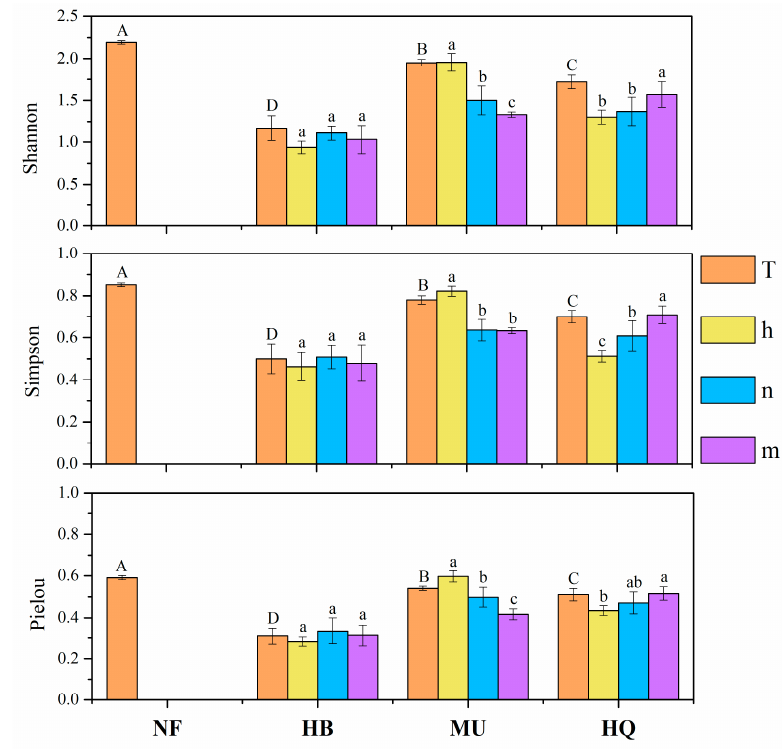
Figure 2. Diversity indices (±SE) for Ectomycorrhizae (EM) fungal communities in P. sylvestris natural forest and plantations in three sandy lands ( n =5). T for the composed value (included five mixed replicates by adding one of five samples in each age group in the same sandy land together) of each sandy land. h for half-mature, n for nearly mature, m for mature. The capital letters indicate significant differences among sandy lands (columns in orange), the lowercase letters indicate significant differences among age groups within the same sandy land, p < 0.05.